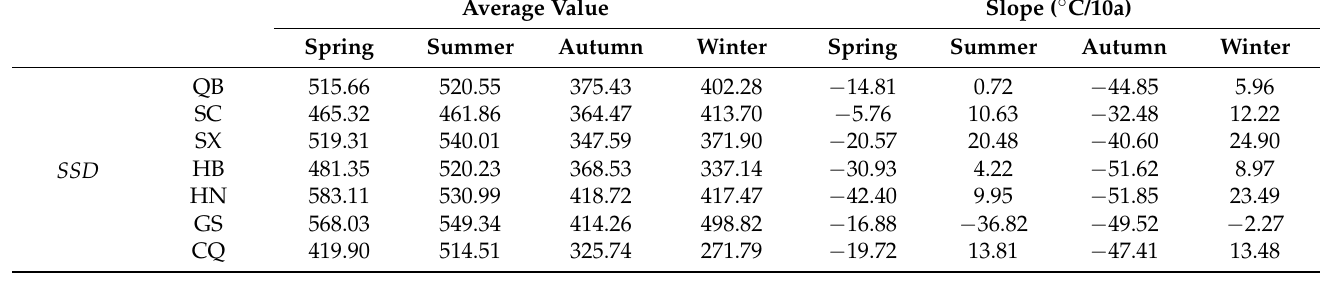
Table 8. Seasonal average and change trend rate of SSD in the QBM.